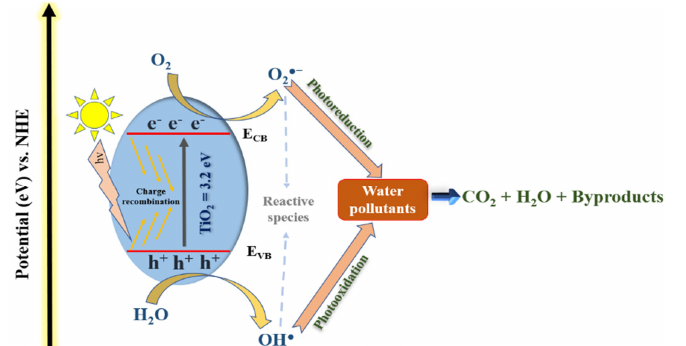
Figure 4. Mechanism of the photocatalytic action of a TiO 2 sample in wastewater treatment under the irradiation of distinct photon sources.